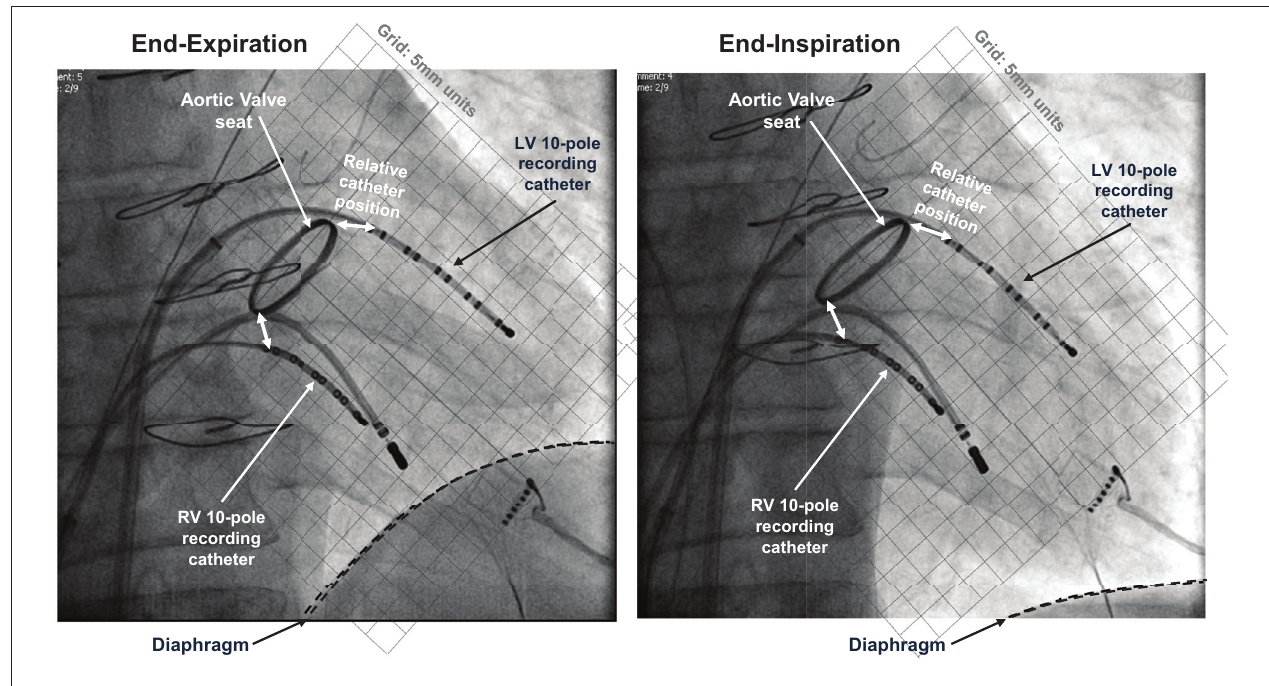
FIGURE 1 | Electrical recording methods. Fluoroscopic images at end-expiration and end-inspiration of respiratory cycle, both at end-diastole. 10-pole electrode catheters are located in the left and right ventricles, with additional pacing catheter at right